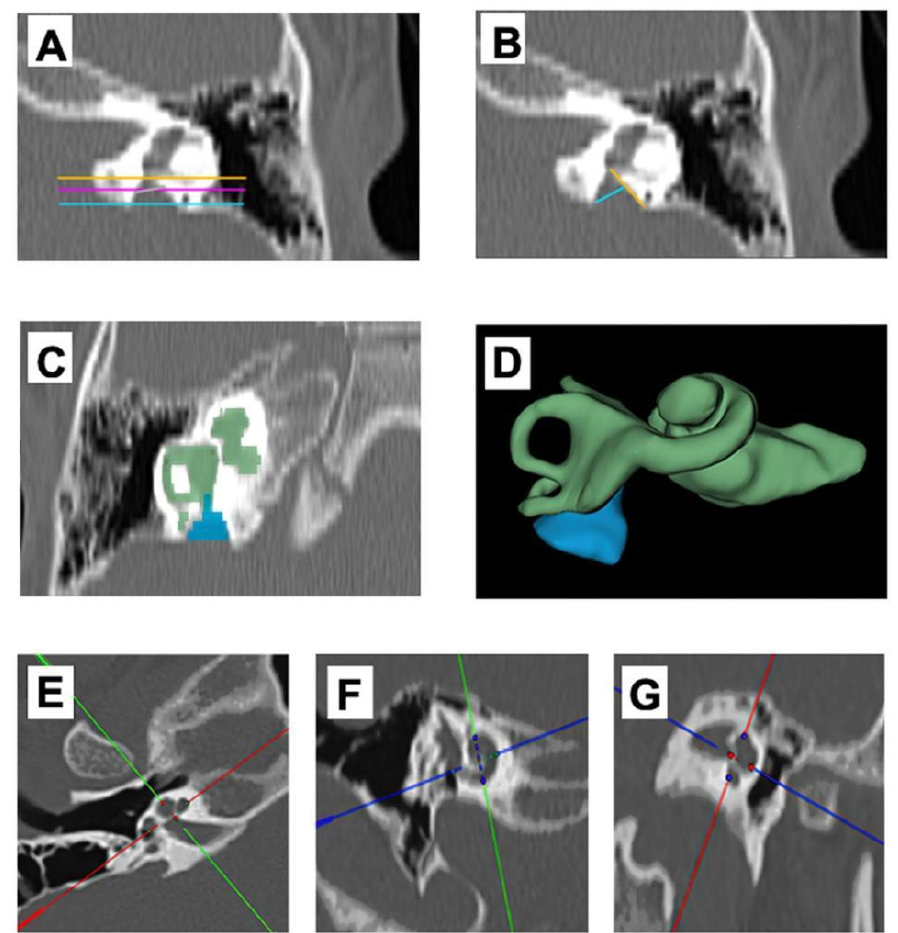
Figure 1. Illustration of measurements of VAD width, 3D segmentation of VAD and inner ear, and linear cochlear metrics measurements. ( A ) Left Axial CT image of temporal bone showing the method for measuring VA midpoint width, ( B ) the method for measuring VA opercular width. ( C , D ) showing the 3D segmentation of the inner ear and EVA. ( E – G ) showing cochlear metrics using OTOPLAN ®